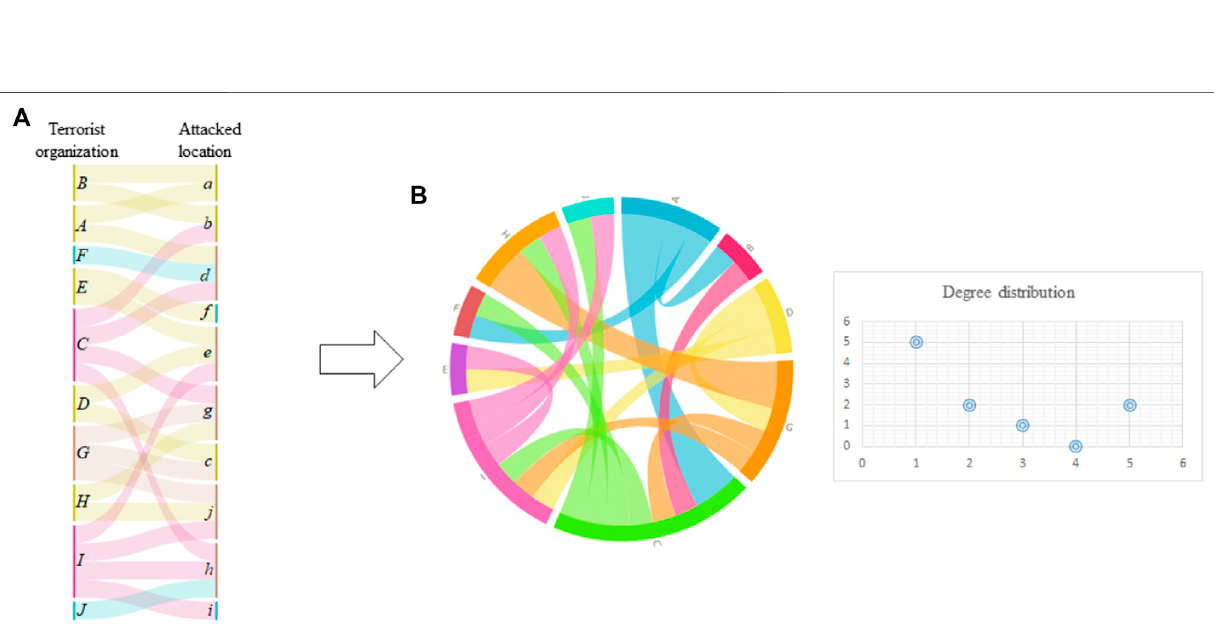
FIGURE2| Terroristorganizationalliancenetworkconstructiondiagram;In (A) ,theletters A to G aretheterroristgroups ’ name,and a − j arethelocationsattacked byaterroristgroup;iftheterroristgroupsattackedthesamelocationinthesametime,wethinkthatthereisacausetolinkthesetwonodes.Thuswecangettheterrorist group network as in (B)